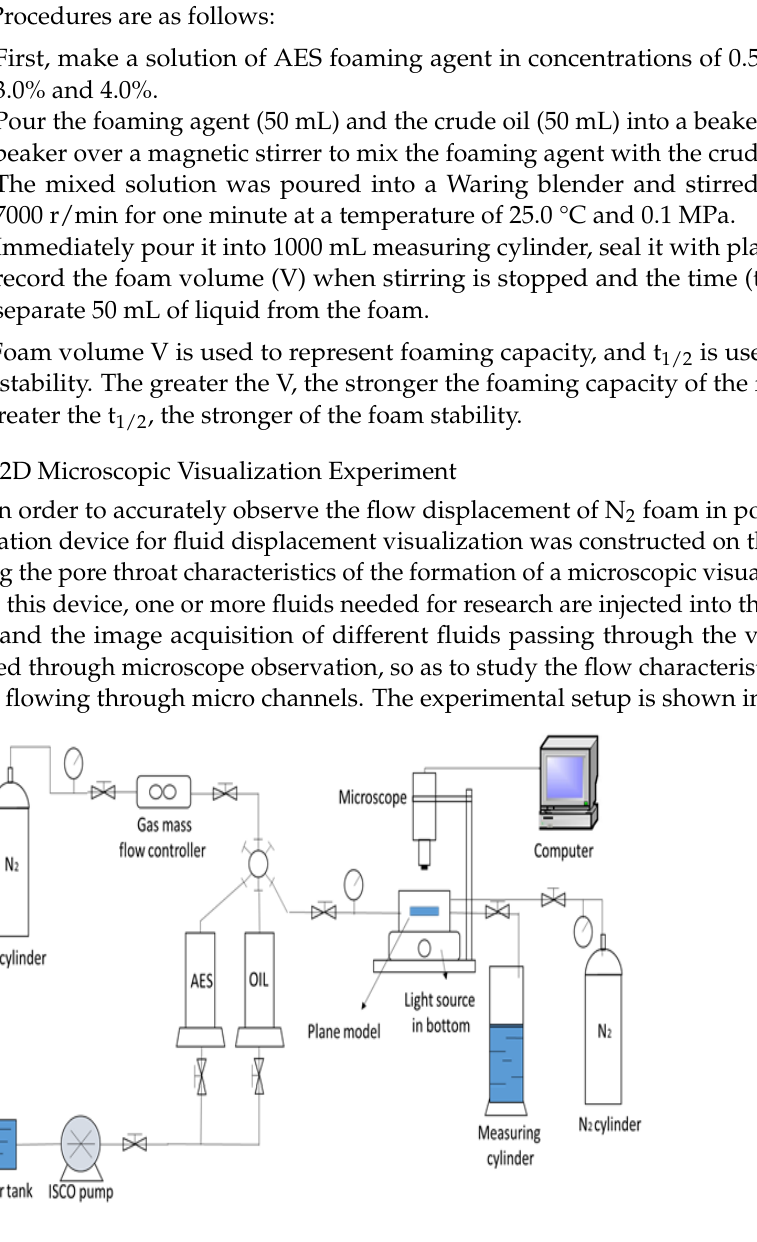
Figure 1. Flow chart of 2D microscopic visualization